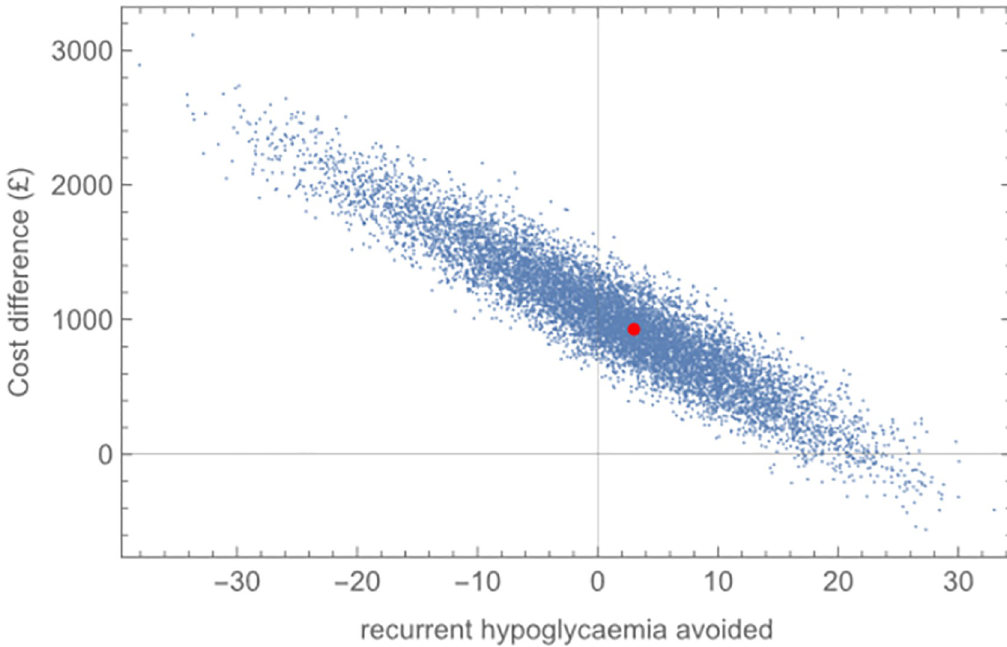
Fig 4. Cost-effectiveness plane (baseline value shown in red). Cost differential between care under HS2 intervention and standard care plotted against number of recurrent hypoglycaemia cases avoided. 10,000 simulated pairs in which recurrent hypoglycaemia incidence and severity rate vary. Baseline (red) cost difference +£929 for +3.00 avoided cases.